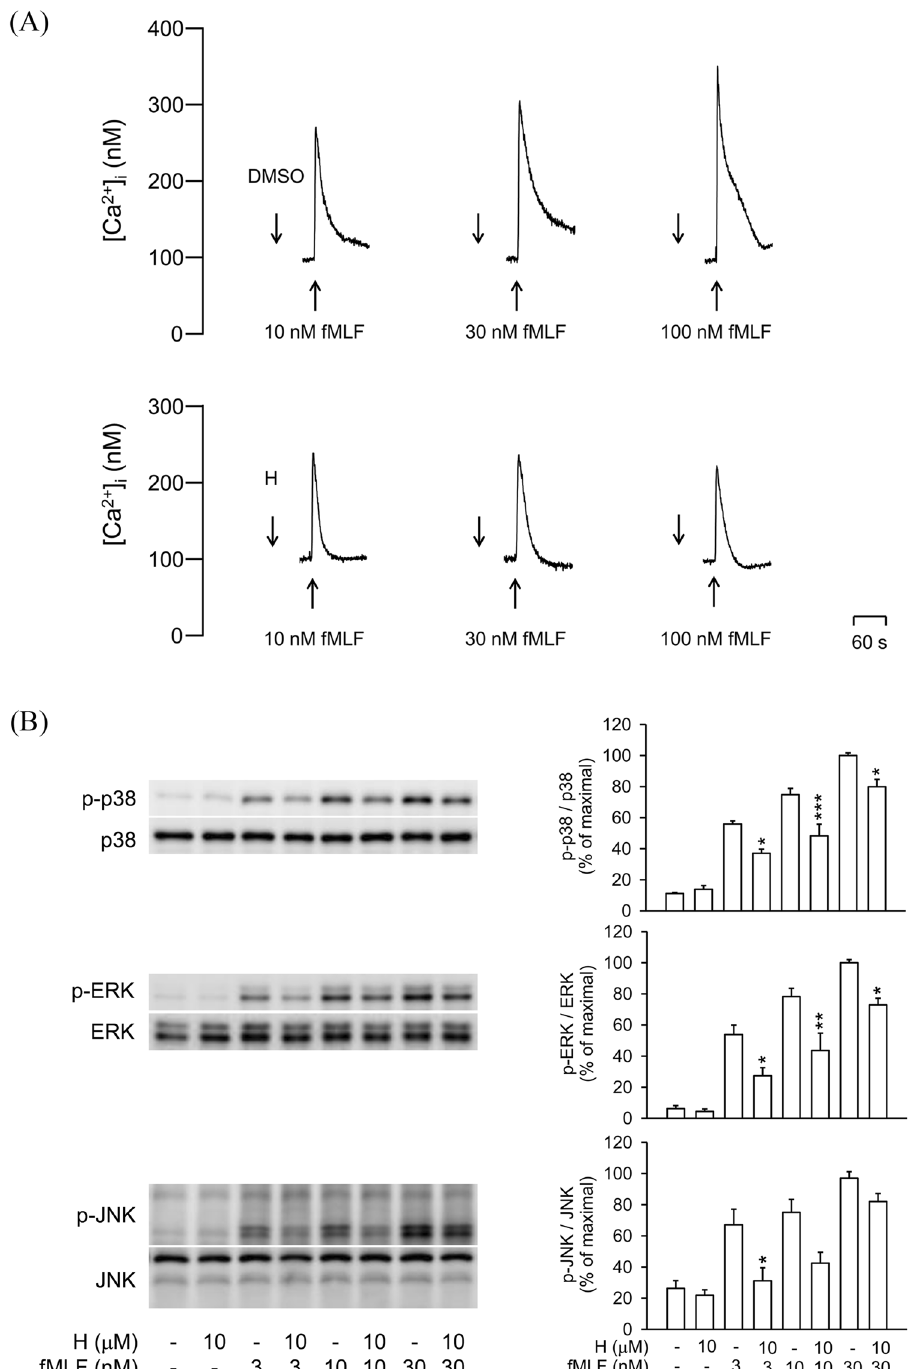
Figure 9. Honokiol inhibits Ca 2 + mobilization and MAPKs phosphorylation in fMLF-activated human neutrophils. ( A ) Fluo-3/AM-labelled human neutrophils were incubated with 0.1% DMSO (as control) or honokiol (H; 10 μ M) for 5 min. Cells were activated by fMLF and mobilization of Ca 2 + was determined in real time by using a spectrofluorometer. Representative traces are shown ( n = 7). ( B ) Human neutrophils were incubated with 0.1% DMSO (as the control) or honokiol (10 μ M) for 5 min before stimulation with or without fMLF for another 25 s. Phosphorylation of p38, ERK, and JNK was analyzed by immunoblotting with antibodies against the phosphorylated and total form of each protein. All the Western blotting experiments were performed under the same condition. After transferred the blots onto nitrocellulose membranes, we immediately cropped the targeted blots according to referenced indicating markers, and then targeted proteins were immunoblotted with its specific monoclonal antibody. Data are normalized to the corresponding total protein level and expressed as mean ± S.E.M. relative to the mean maximal ratio ( n = 4). * P < 0.05; ** P < 0.01; *** P < 0.001 compared with corresponding